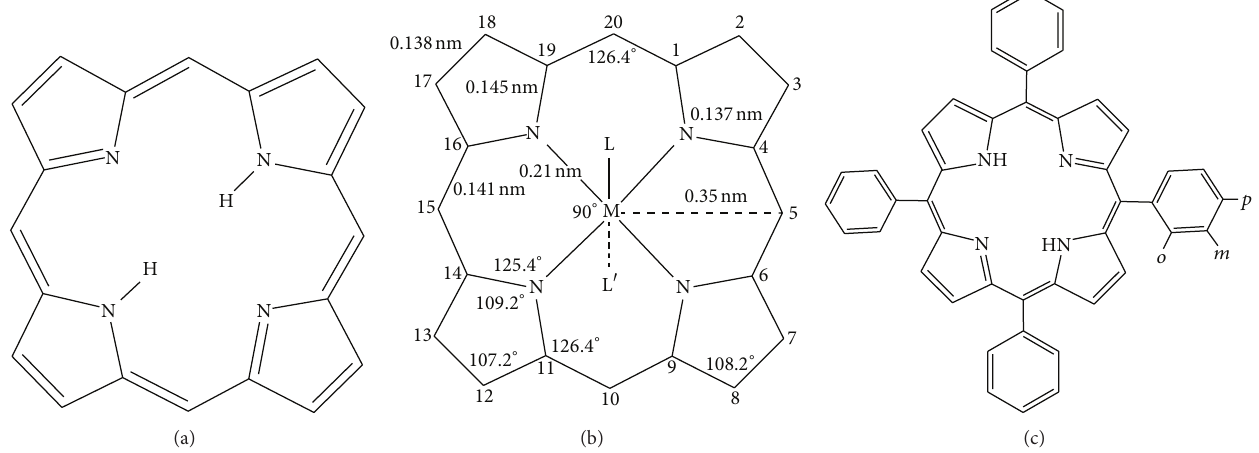
Figure 1: (a) Structure of the tetrapyrrolic porphin macrocycle; (b) bond lengths, bond angles, and positions (1 to 20) of possible peripheral substituents in the respective metallic complex; and (c) ortho -, meta -, and para -positions in a tetraphenylporphyrin (H 2 T( o -, m -, p